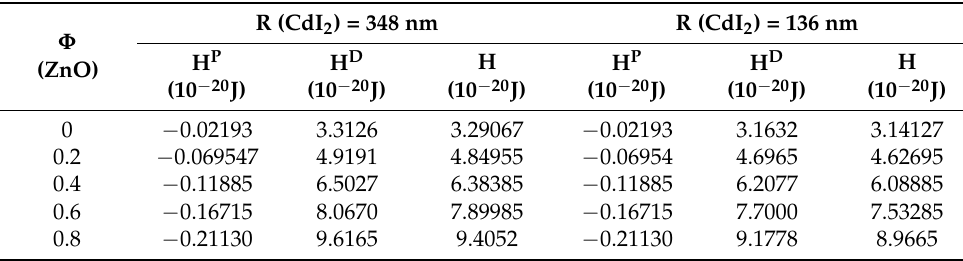
Table 4. The nonretarded Hamaker constants as a function of the volume fraction Φ of NPs